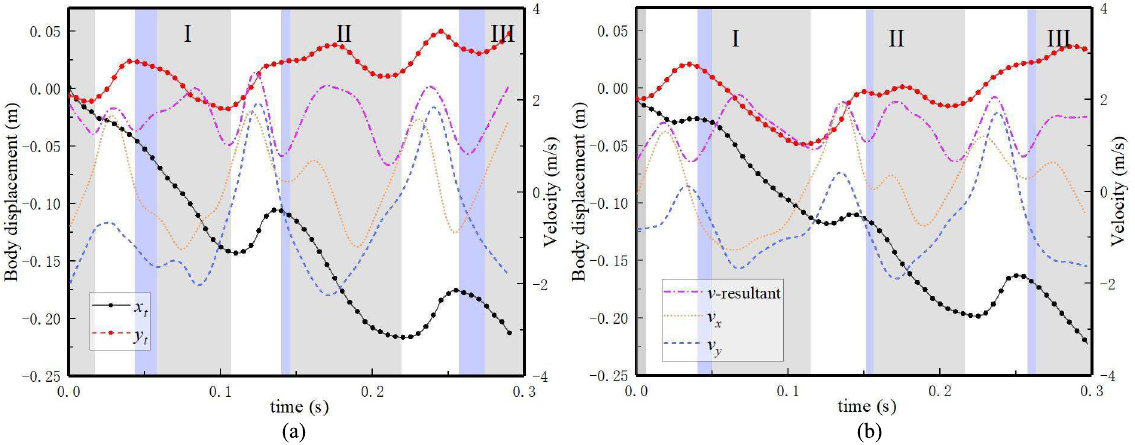
Figure 7. Time variations of wing tip kinematics of: VC1 ( a ); and VC2 ( b